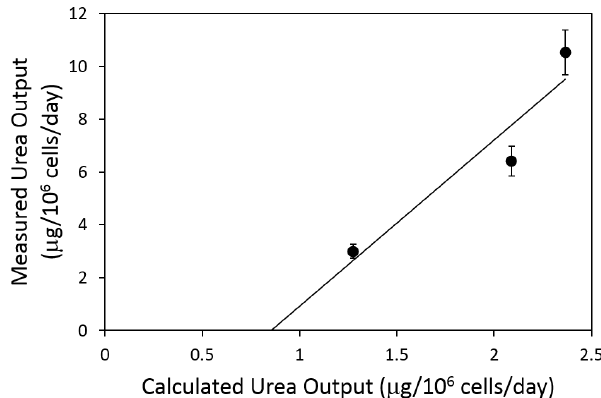
Figure 5. Comparison of measured and calculated urea fluxes. The measured urea secretion rate is plotted against the urea cycle output predicted by MFA using the data set shown in Table 1. Measured values are expressed as averages ± S.E.M. for n = 3 replicates. The least-square fit line is shown. R 2 = 0.89.